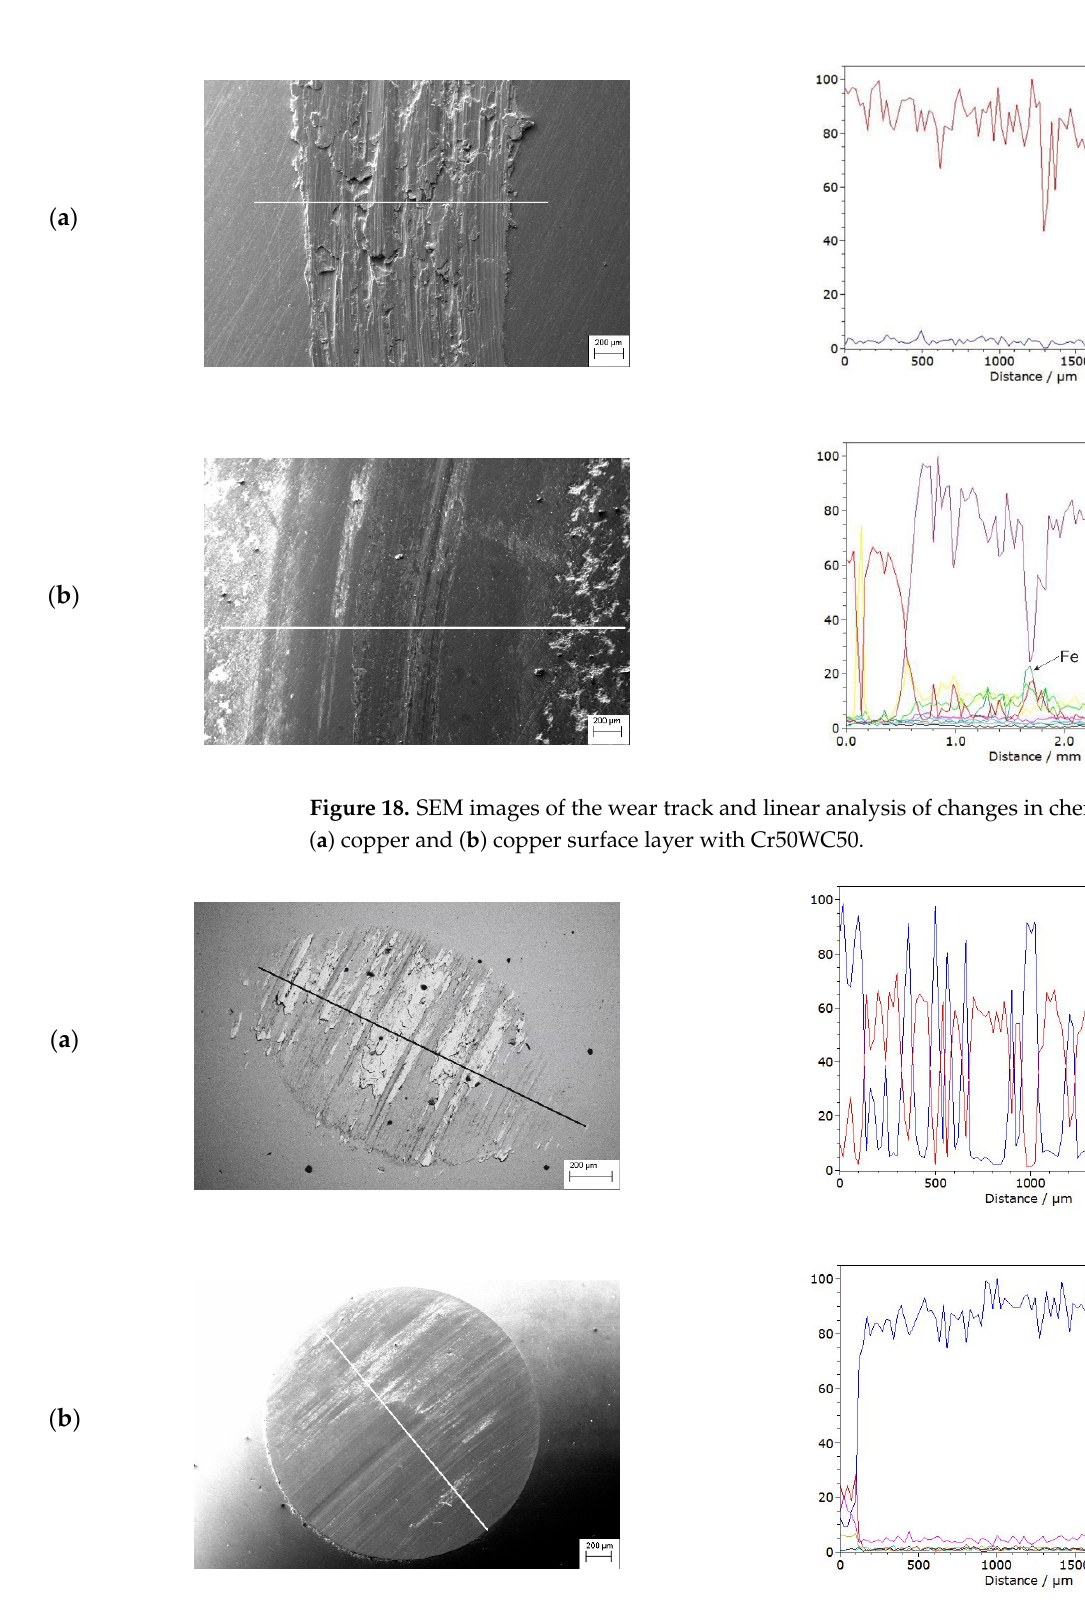
Figure 17. Representative 2D profiles of the wear track for ( a ) copper and ( b ) copper after laser alloying (Cr50WC50).